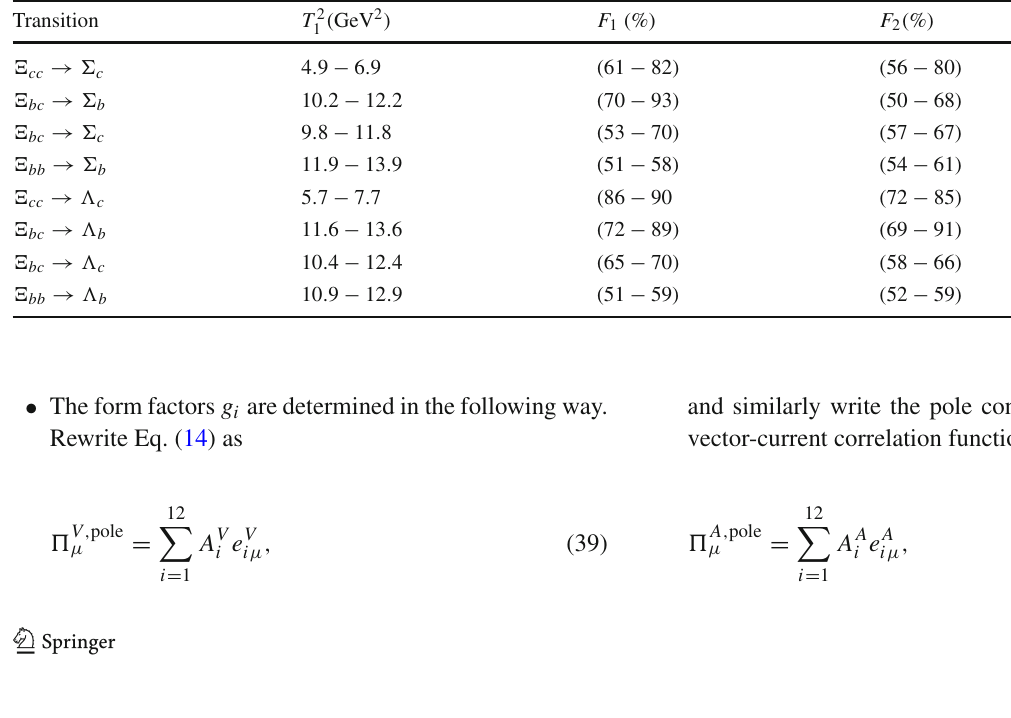
Table 7 The windows of the Borel parameter T 2 Eq. (36) for the form factors in different transitions. T 2